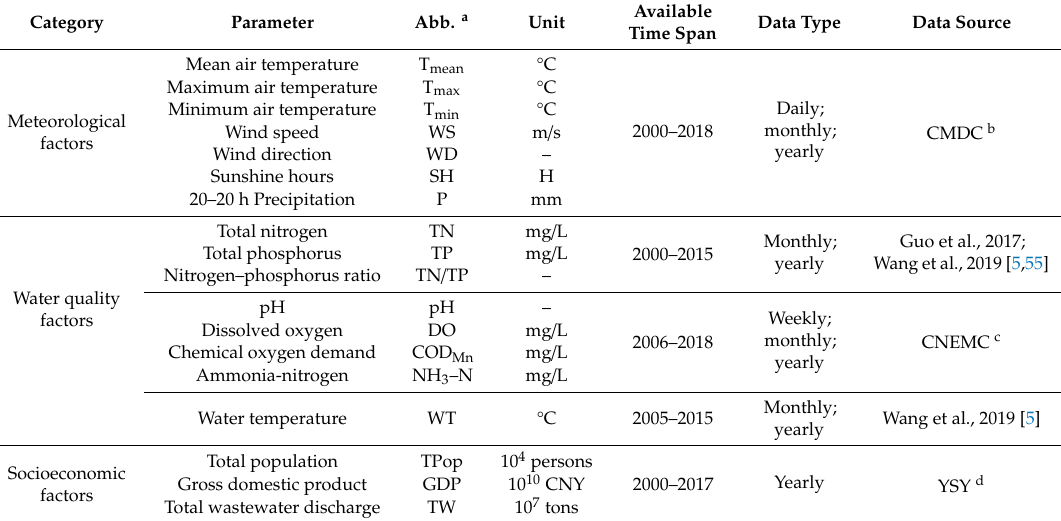
Table 1. Influencing factors used in this